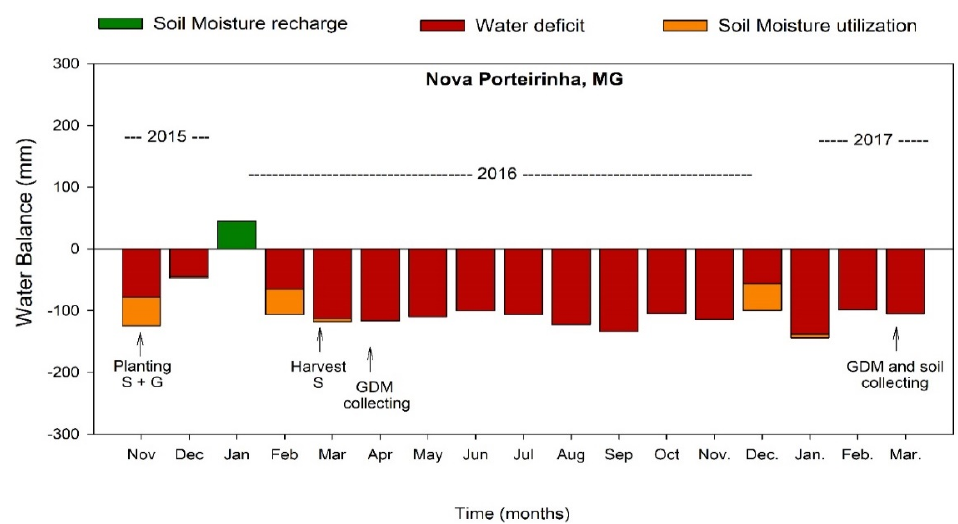
Figure 1. Water balance during the crop-years of 2015/2016 (crop-year 1) and 2016/2017 (crop-year 2) in Nova Porteirinha, MG, Brazil. The bar represents the mean of the month. GDM: grass dry matter; S: sorghum; G: grasses. Table 1. Soil characterizations (soil chemistry and physics) in the experimental area in different soil layers (0.0–0.1; 0.1–0.2; 0.2–0.3